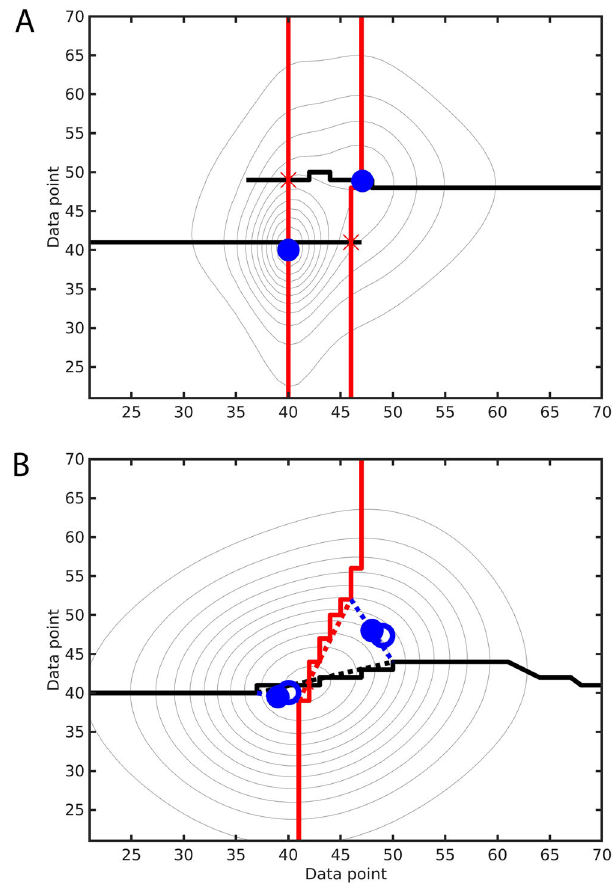
Fig. 4 Contour plot of the synthetic 2D spectrum representing two overlapping cross-peaks (blue circles). First, DEEP Picker predicts 1D peak positions for each column (row) labeled in black (red). A Next, the 2D peak-picking algorithm uses intersections of black and red lines to de fi ne 2D cross-peaks, while removing false positive peaks (red crosses) using the approach described in the text. B If both black and red lines deviate from perfect vertical and horizontal lines, respectively, the 2D peak-picking algorithm will replace the intersection peak with two cross-peaks (blue fi lled circles) near the true positions (blue open circles) using the approach described in the